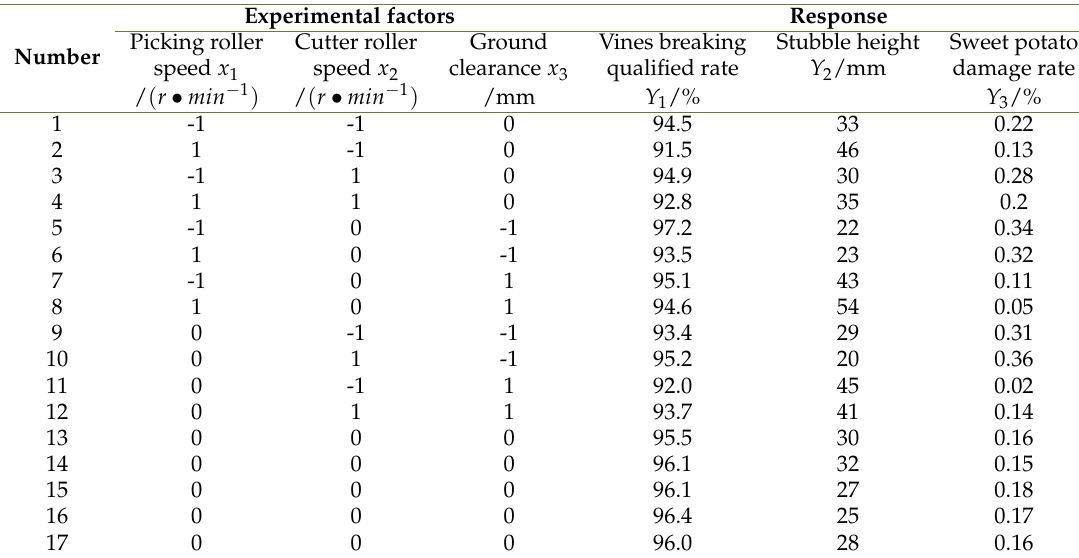
Table 3. Test scheme and